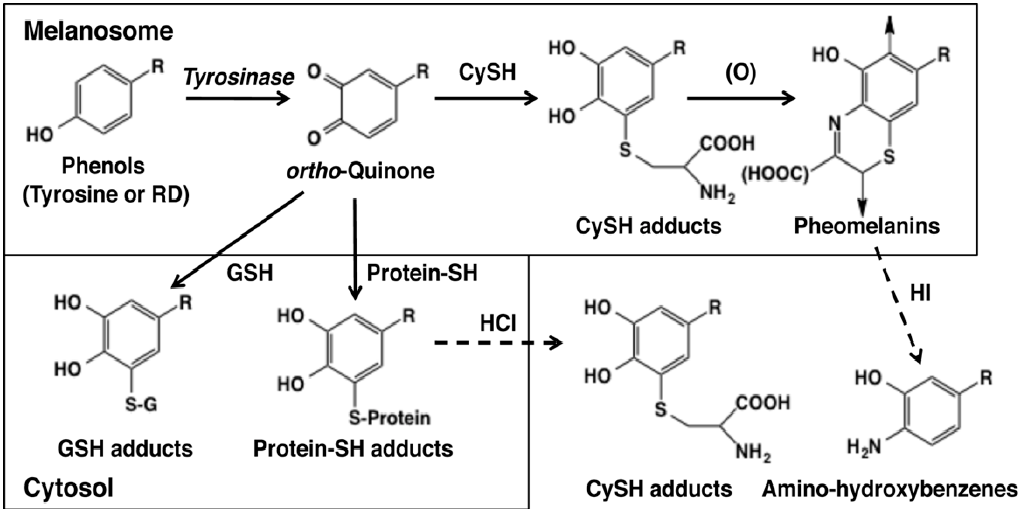
Figure 3. Metabolic pathways for phenols (such as RD or L -tyrosine) catalyzed by tyrosinase in melanin-producing cells [32]. The oxidation of RD or tyrosine with tyrosinase gives RD-quinone or dopaquinone as an immediate product in melanosomes. These quinones bind CySH to give CyS-RD-catechol or CyS-Dopa, respectively. They are oxidized to RD-pheomelanin and Dopa-pheomelanin. RD-eumelanin and Dopa-eumelanin are also produced in melanosomes [15]. RD-pheomelanin and Dopa-pheomelanin can be analyzed as amino-hydroxybutylbenzene and amino-hydroxyphenylalanine, respectively, after HI hydrolysis [32,44]. When leaked to the cytosol, these quinones bind to GSH to give GS-RD-catechol or GS-Dopa, respectively. CyS-catechols and GS-catechols can be analyzed as such by HPLC. Quinones that have escaped from binding to CySH or GSH react with protein-SH to form protein- S -RD-catechol or protein- S -Dopa. These protein adducts can be analyzed as CyS-RD-catechol or CyS-Dopa, respectively, after HCl hydrolysis [32,38,39].